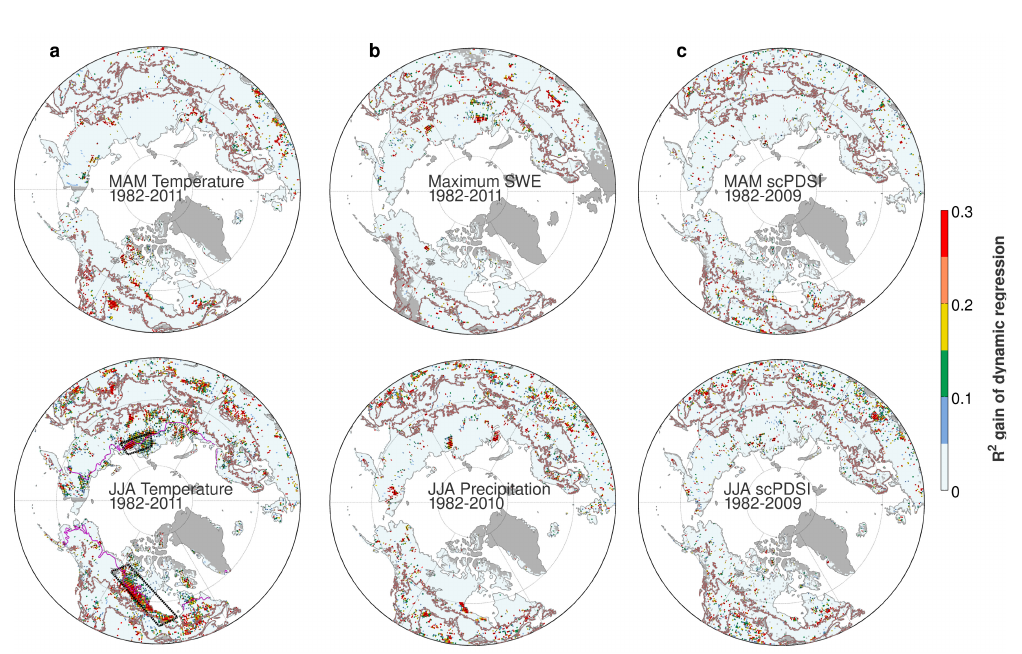
Maps of additional variance ( R 2 ) explained by the univariate dynamic Kalman filter regression model between NDVI and potential climate drivers compared with a standard least squares linear regression model. R 2 gain for summer NDVI regressed onto: ( a ) spring and summer temperature; ( b ) spring and summer water supply; and ( c ) spring and summer soil moisture (scPDSI). A 10-year high-pass filter was applied to the data prior to analysis. R 2 values are shown for grid points where the dynamic regression model was selected over the standard fixed model based on the minimum Akaike Information Criteria